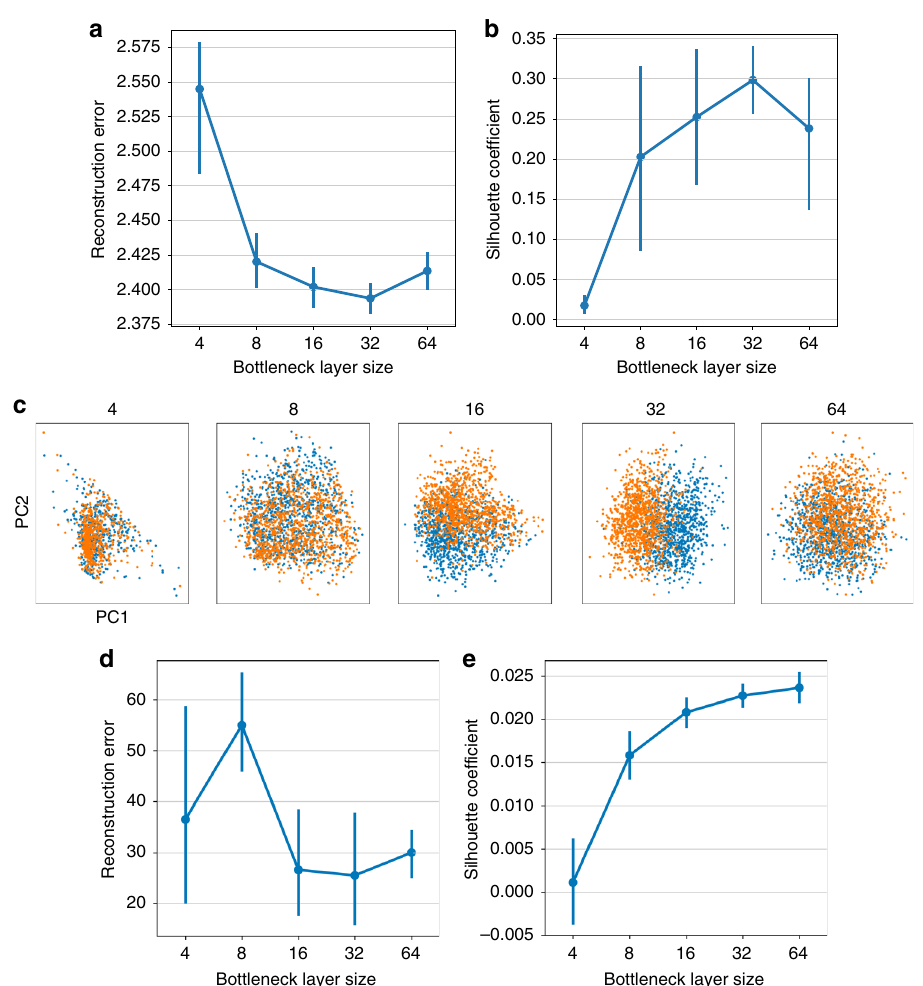
Fig. 10 ReconstructionTraining error correlates with DCA performance and can guide hyperparameter selection. a , b show the distribution of the reconstructiontraining error and Silhouette coef fi cients across fi ve different bottleneck layer sizes, respectively. Error bars represent standard error across fi ve iterations. c shows exemplary PCA results derived from denoised expression data across the fi ve bottleneck layer con fi gurations. Colors represent simulated celltypes. d , e show the distribution of the reconstruction error and Silhouette coef fi cients when applying analogous analysis to the Zheng et al. 12